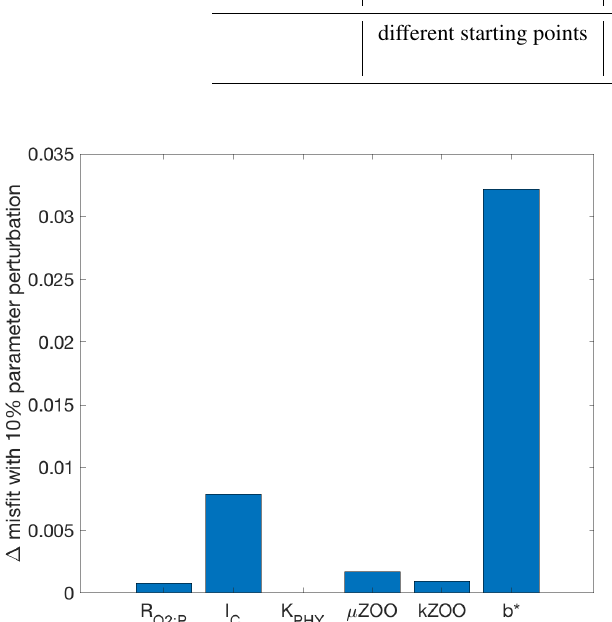
Figure 3. Bar graph of the misfit change due to individual parameter perturbations from their target value to + 10% of their